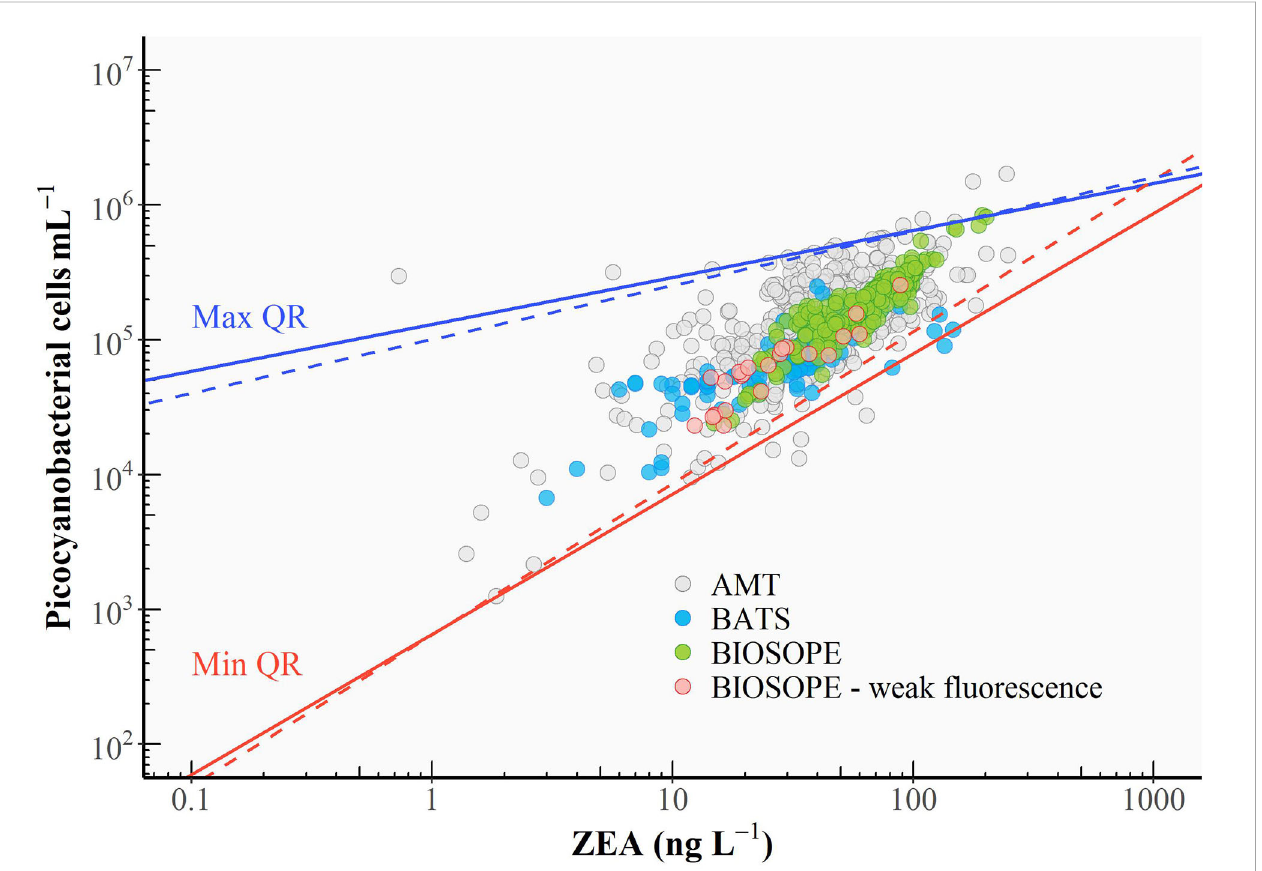
FIGURE 6 Relationship between cell abundance of picocyanobacteria and the concentration of zeaxanthin (ZEA). A linear regression was performed (black line), and the 95% con fi dence interval for the linear regression line is shaded in grey. The upper (solid blue line) and lower (solid red line) boundaries correspond to the maximum (99th) and minimum (1st) quantiles, respectively (see text for the calculation). Dashed lines represent the re- fi tted quantile regressions after identi fi ed outliers were excluded. Red circles represent the cases where the Prochlorococcus cell number was derived from DVChl- a concentration as the fl uorescence signal measured in fl ow cytometry was too